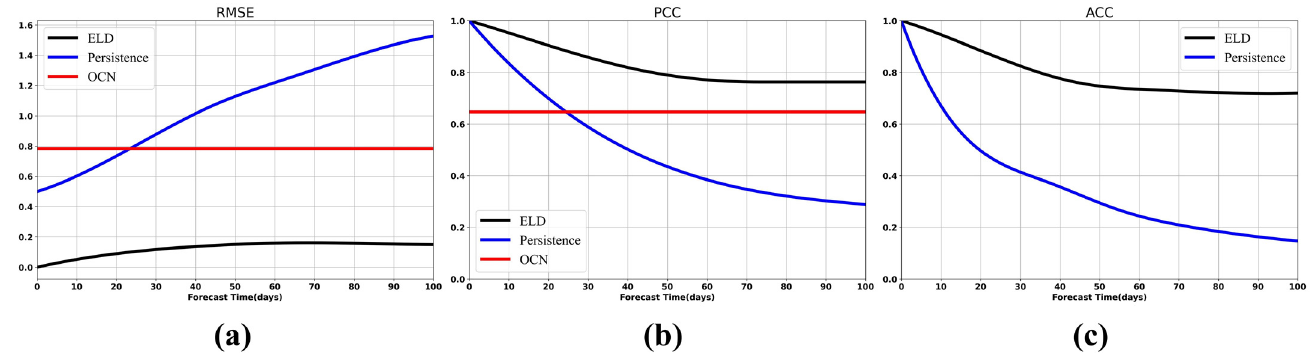
Figure 8. Comparison of ( a ) RMSEs, ( b ) PCCs, and ( c ) ACCs from persistence, OCN forecasts, and EOF–LSTM–DNN (ELD) forecasts. Calculated from daily forecasts over a 100-day range for 2017– 2019.